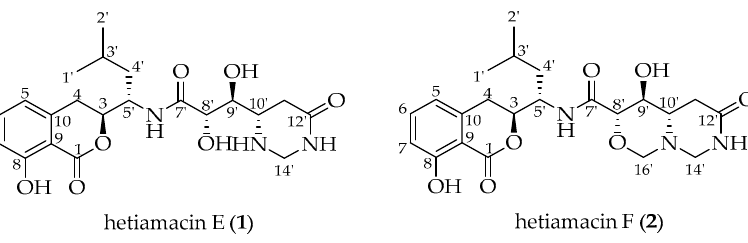
Figure 1. Chemical structures of hetiamacin E ( 1 ) and hetiamacin F ( 2 ).